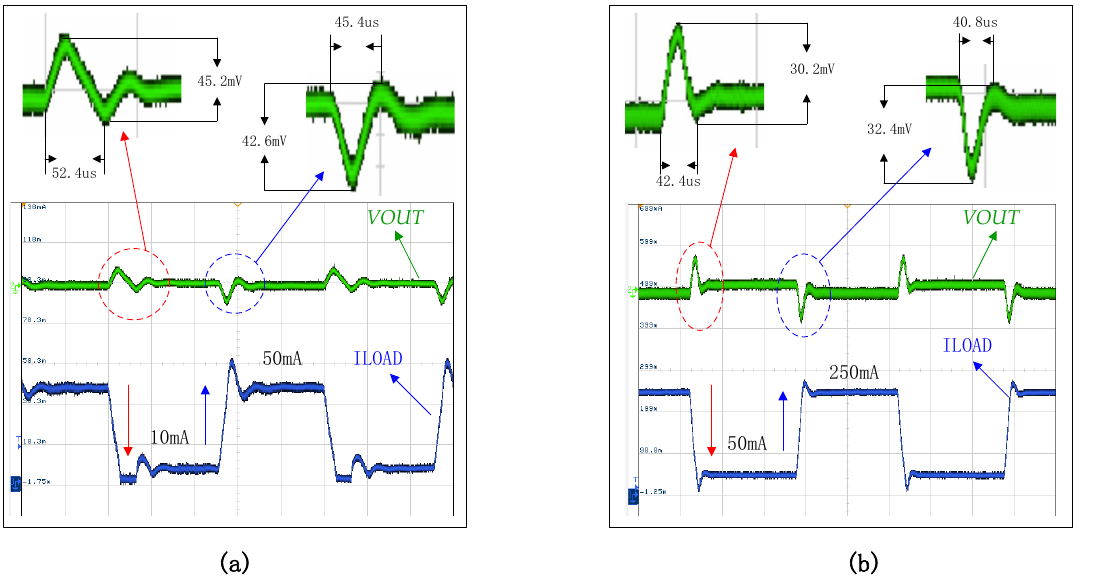
Figure 16. Experimental results of the load switching response of the boost converter. ( a ) The load is switched between 10 mA and 50 mA at the input voltage VIN = 1.5 V. ( b ) The load is switched between 50 mA and 250 mA at the input voltage VIN = 3.6